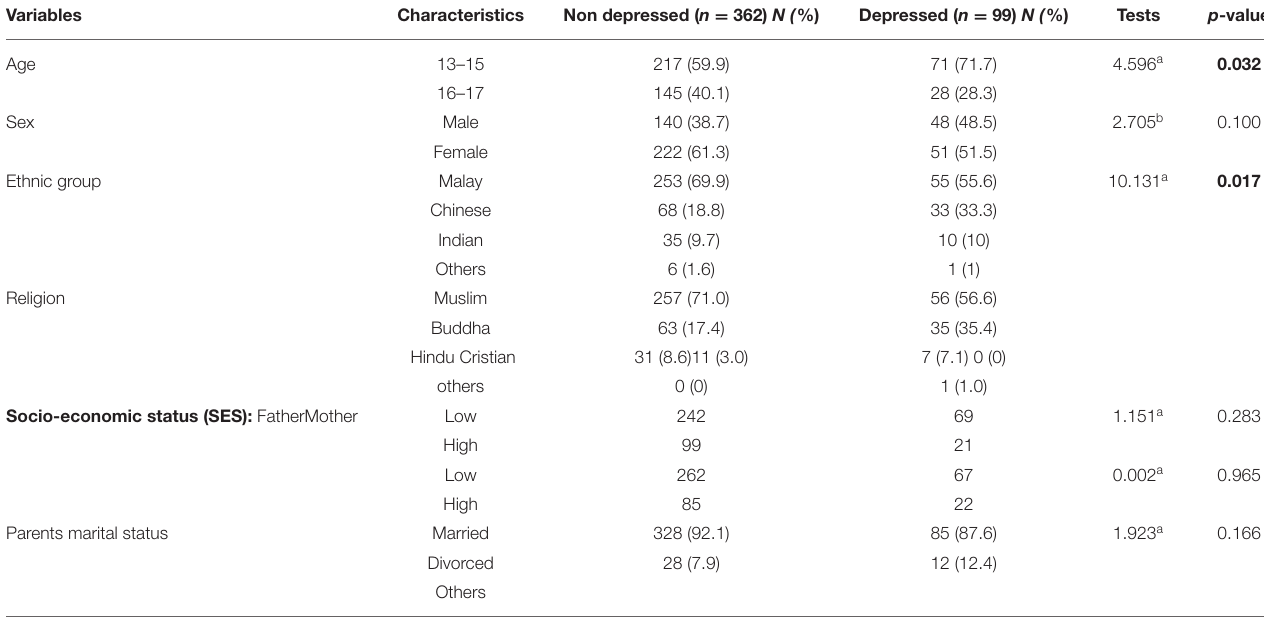
TABLE 1 | Sociodemographic profiles and adolescent depression. Variables